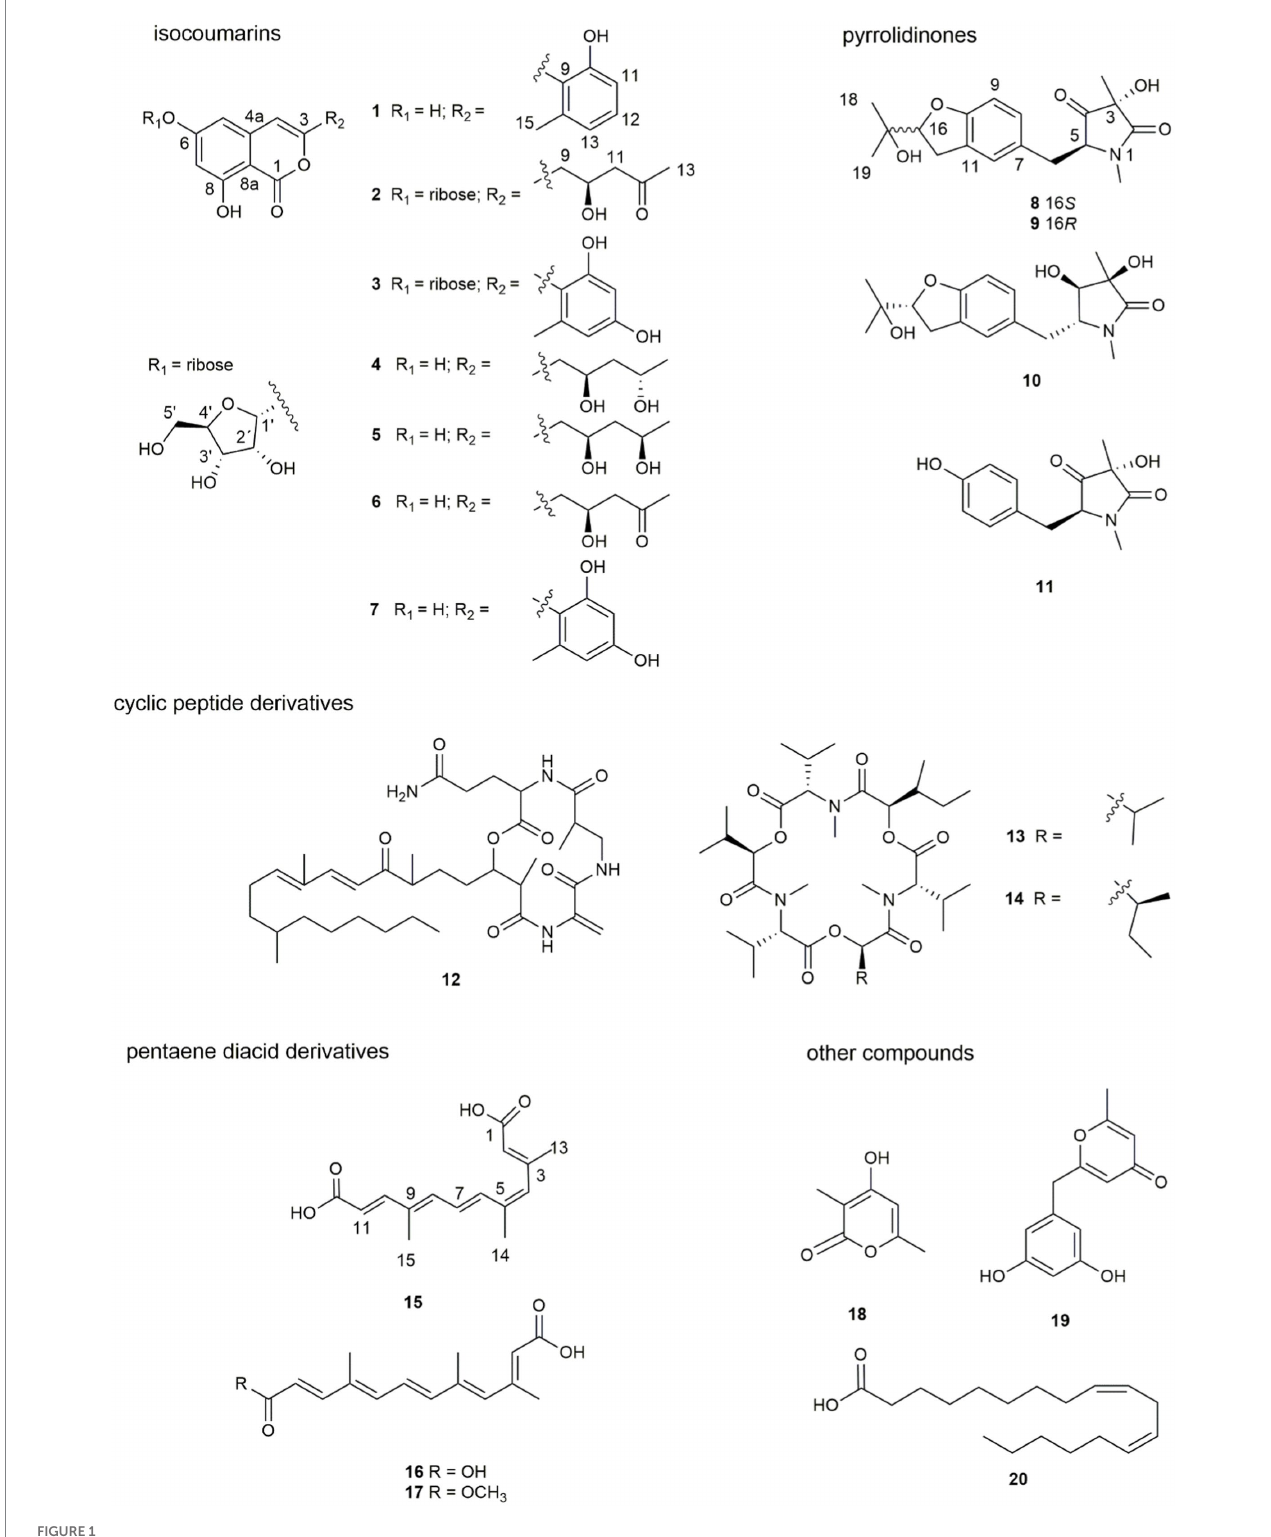
FIGURE 1 Structures of compounds 1 ̶ 20